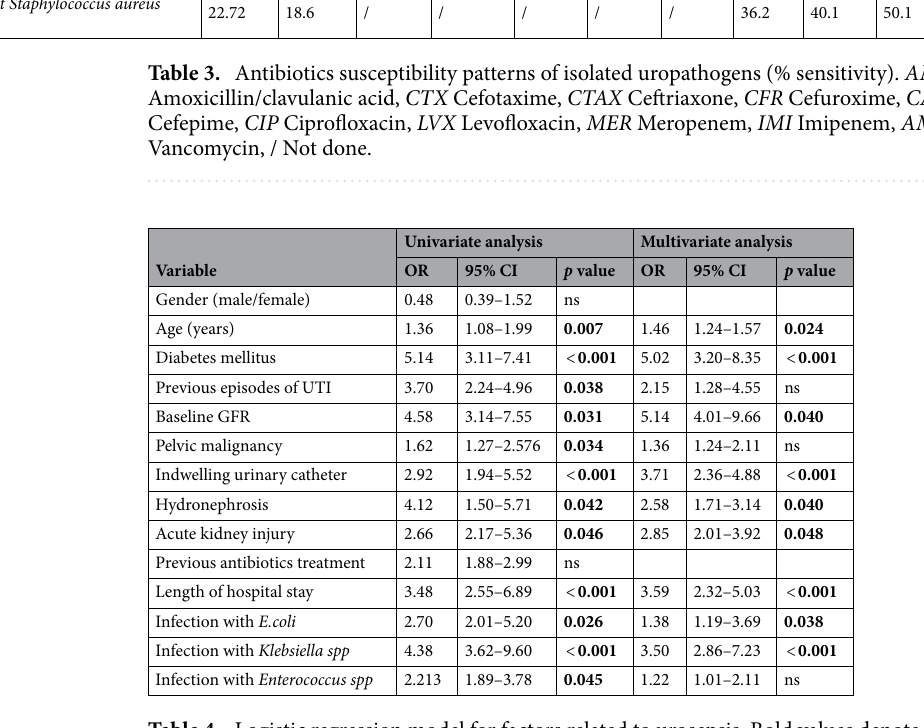
Table 4. Logistic regression model for factors related to urosepsis. Bold values denote statistical significance at the p < 0.05 level. OR Odds ratio, CI Confidence interval, GFR Glomerular filtration rate, ns